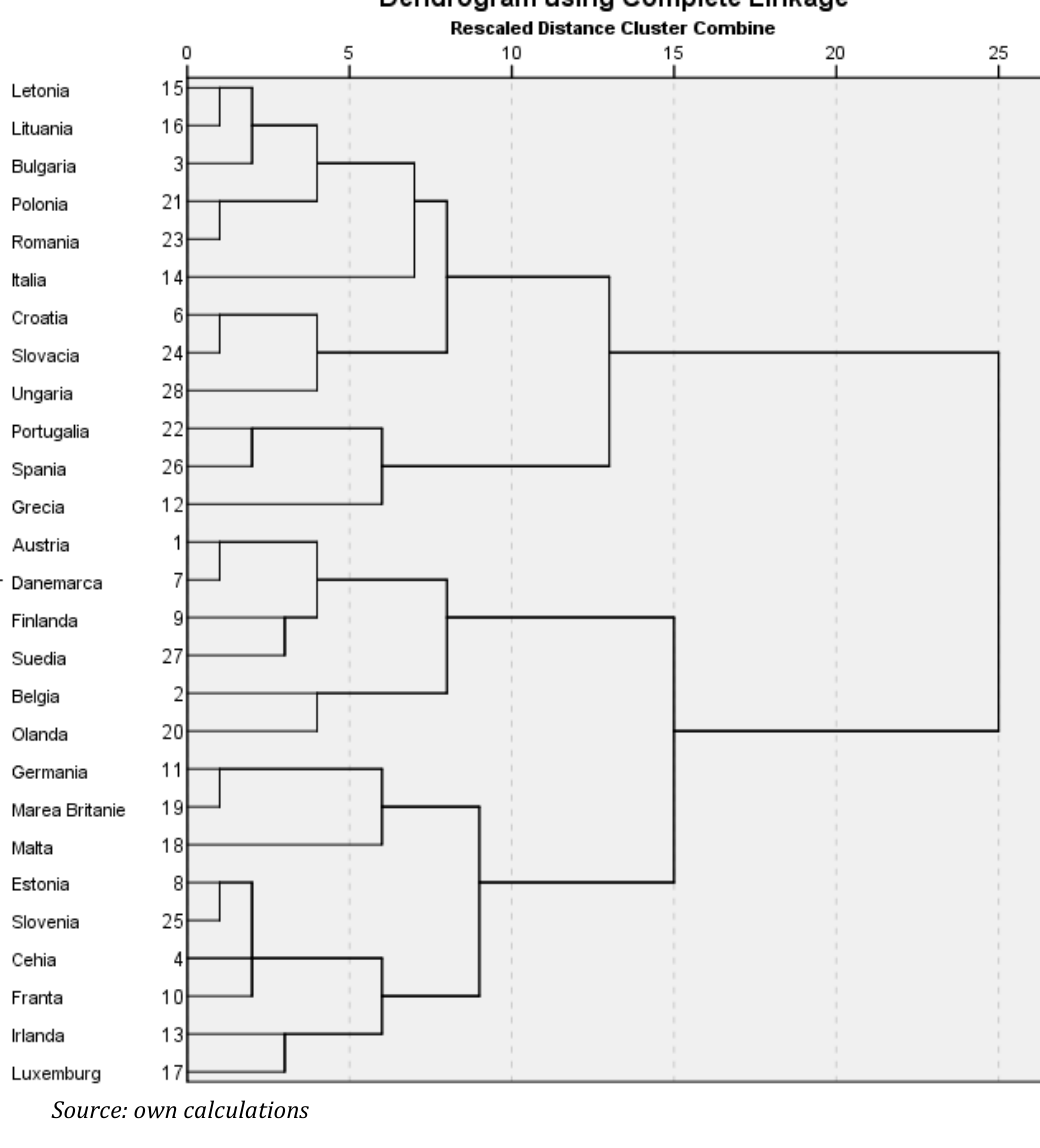
Table 2: EU Member States clusters Cluster State Cluster